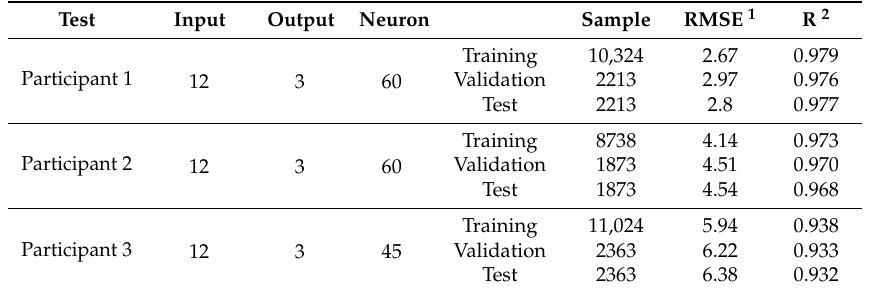
Table 4. The results of the accuracy for TMS by all movements including planar and multiplanar movements as performed by each participant. The outcome of network training for planar movements.